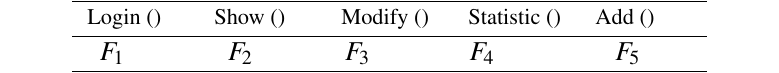
Table 2 Source Code Entities – Numbers corresponding to sequence of function operations Login